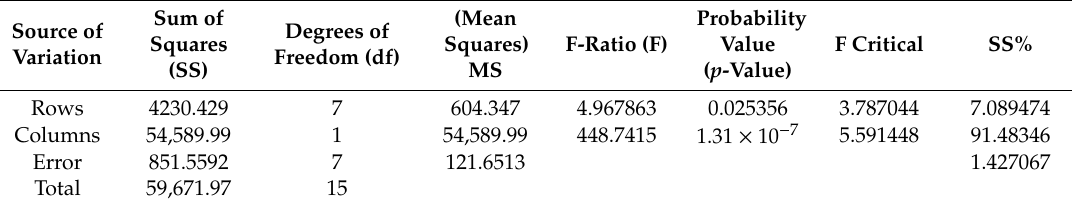
Table A4. ANOVA: Two-Factor without Replication.